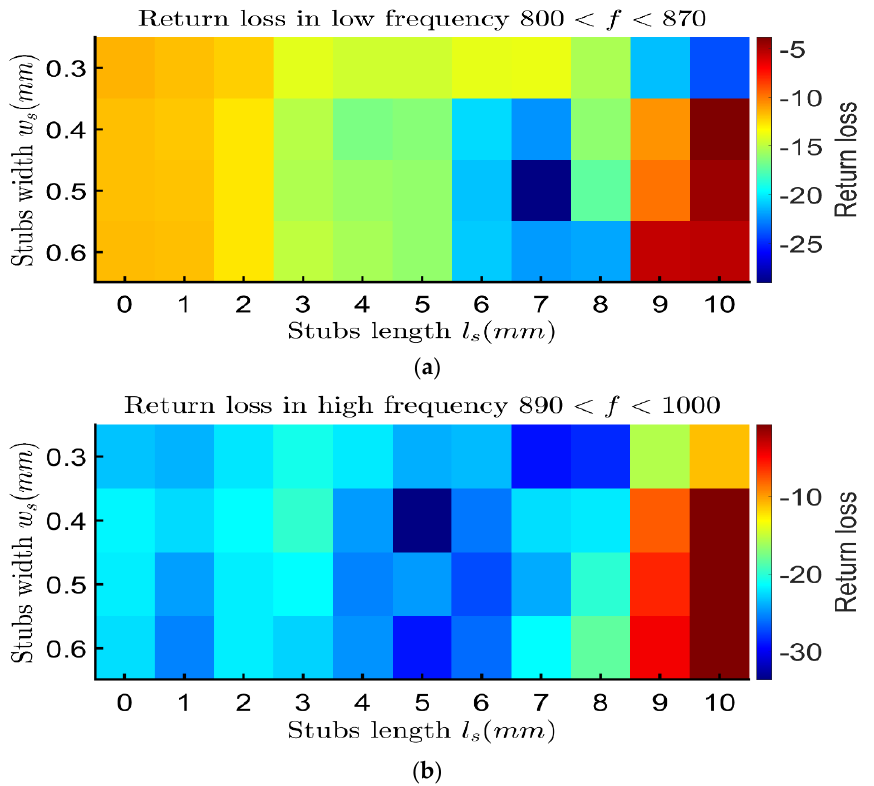
Figure 14. Return loss vs. l s and w s values. ( a ) at low frequency 800 < f < 870, ( b ) at high frequency 890 < f < 1000.